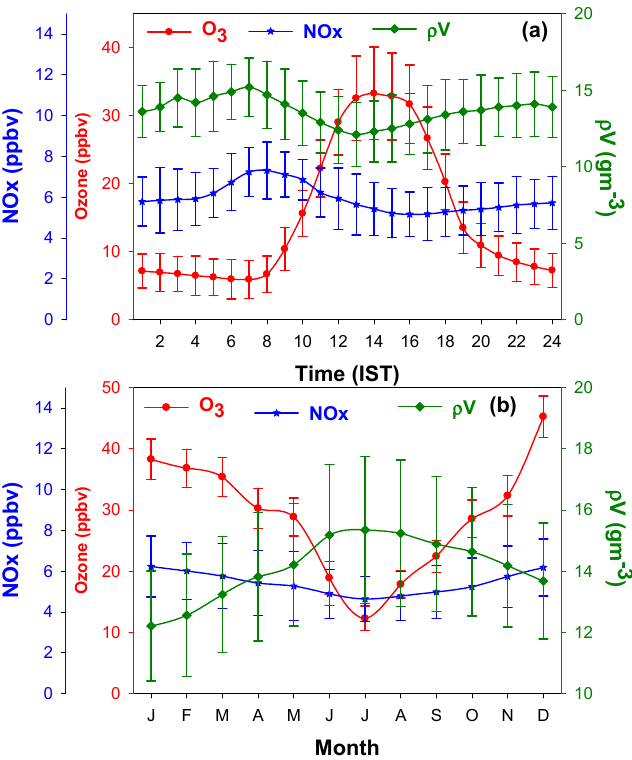
Figure 3. ( a ) Diurnal, ( b ) monthly variation of O 3 , NOx, and water content for the period